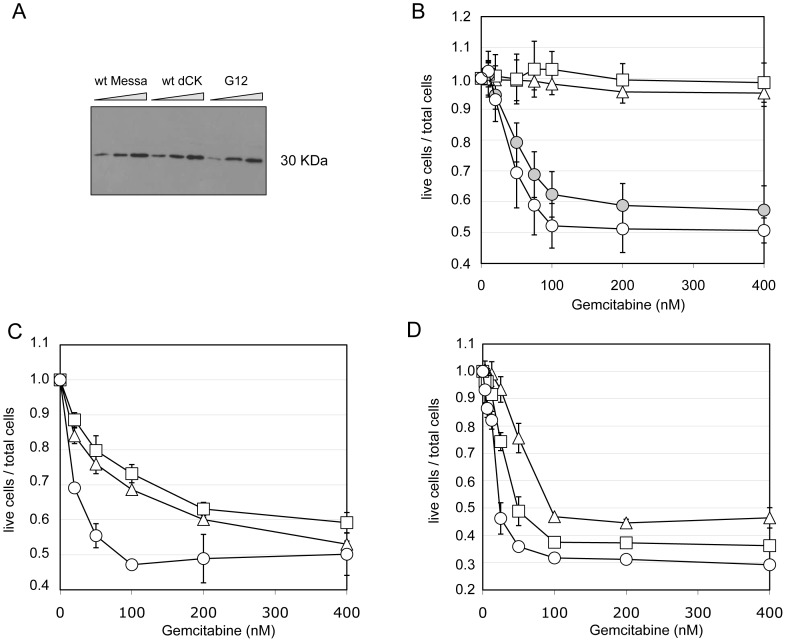
The sensitization phenotype is due to a modified dCK activity.
Panel A. Western Blot analysis of dCK expression levels in different “polyclonal populations”. M: untransduced Messa10K cells; M-dCK: 4 Messa10K populations transduced with wt-dCK gene; M-G12: 4 Messa10K populations transduced with the G12 variant. For each population 6,12 and 24 µg of total protein were loaded on the gel. Panel B. Gemcitabine sensitivity of Messa10K cells transduced with vectors bearing the G12 mutant sequence inserted in a wild-type backbone. Triangles: untransduced cells. Squares: cells transduced with wt-dCK. Empty circles: cells transduced with G12. Full circles: cells transduced with G12/wt-backbone. Results are the average of 6 independent experiments. Panels C and D. Sensitivity to Gemcitabine of HT29 cells (panel C) and of BxPC3 cells (panel D) transduced with one copy of G12 variant per cell. Triangles: untransduced cells. Squares: cells transduced with a wt-dCK vector. Circles: cells transduced with a G12 vector. Results are the average of 2 independent experiments.